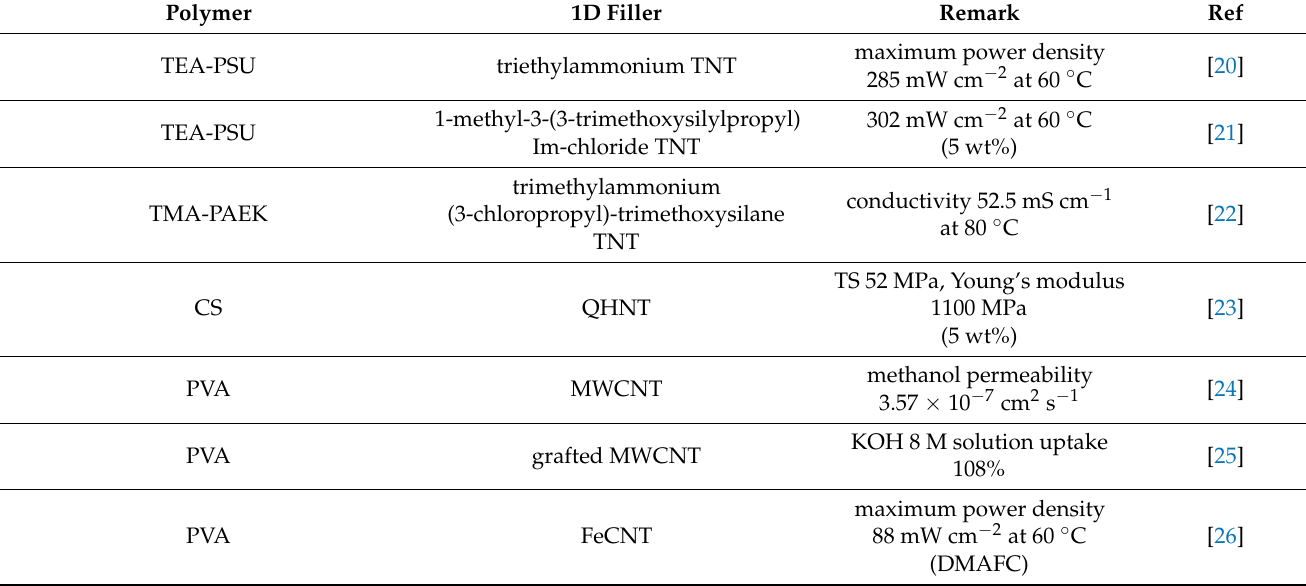
Table 1. Type of polymer and 1D filler in composite AEM with TNT and CNT. Polymer 1D